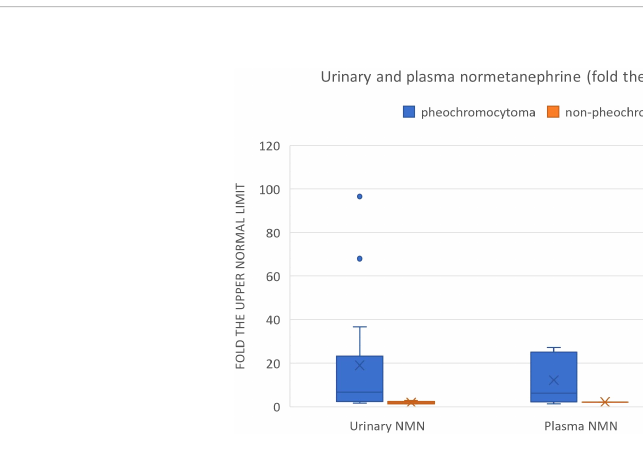
FIGURE 9 Urinary and plasma normetanephrine levels in patients with hemorrhagic pheochromocytoma and adrenal bleeding without pheochromocytoma based on the literature (3, 10, 12, 14, 20, 25 – 29, 30 – 39, 40 – 49, 50 – 54.).